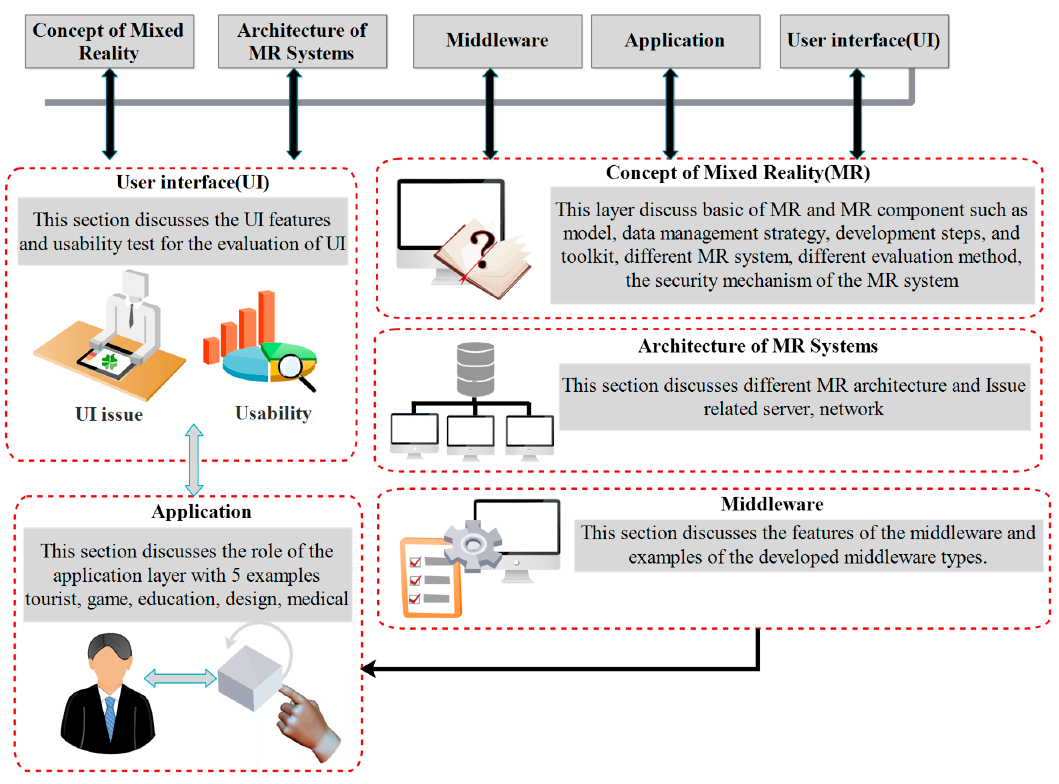
Figure 1. Research layers .